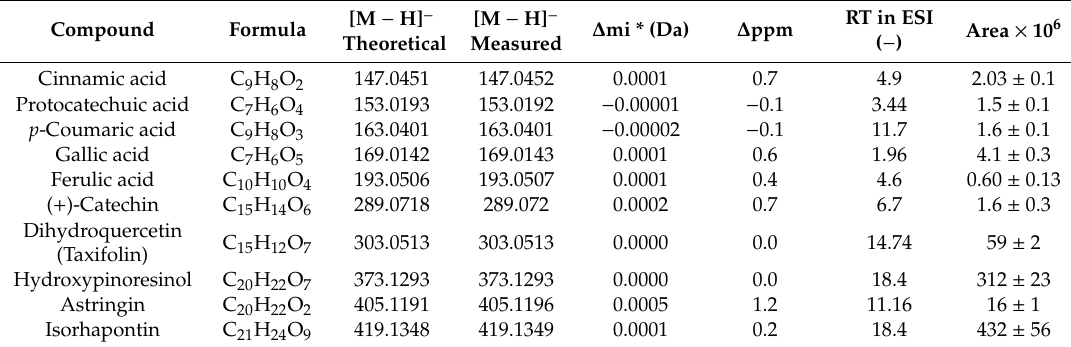
Table 1. Composition of Picea abies extract determined by HPLC-HRMS analysis in negative ionization